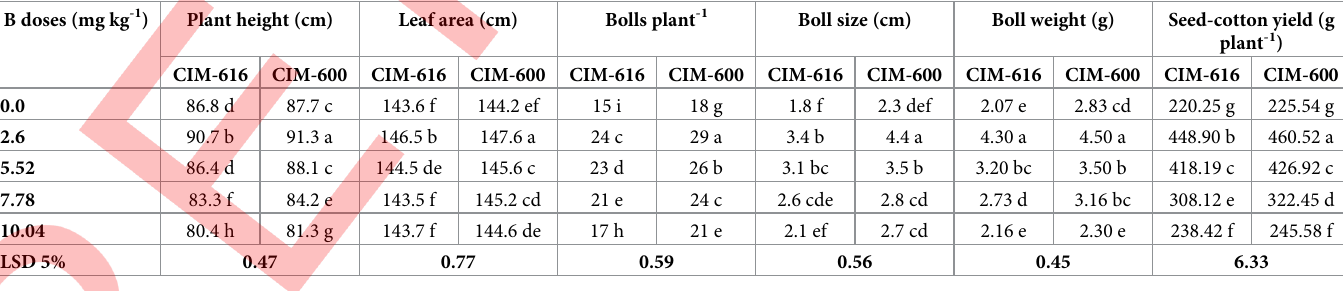
Means sharing similar letters within a column or a row are statistically non-significant (p >